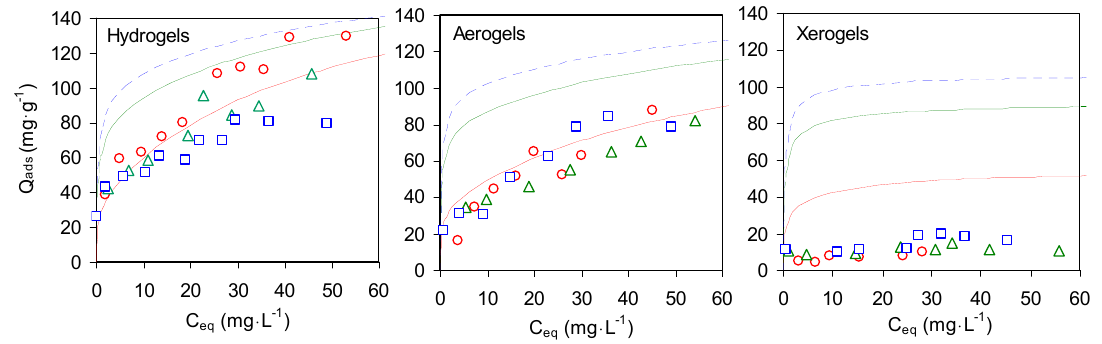
Figure 7. Copper sorption isotherms on hydrogels, aerogels and xerogels of composites A (21% zeolite, red void circles), B (48% zeolite, green void triangles) and C (59% zeolite, blue void squares) and pure chitosan (black filled circles and Langmuir best-fit line).